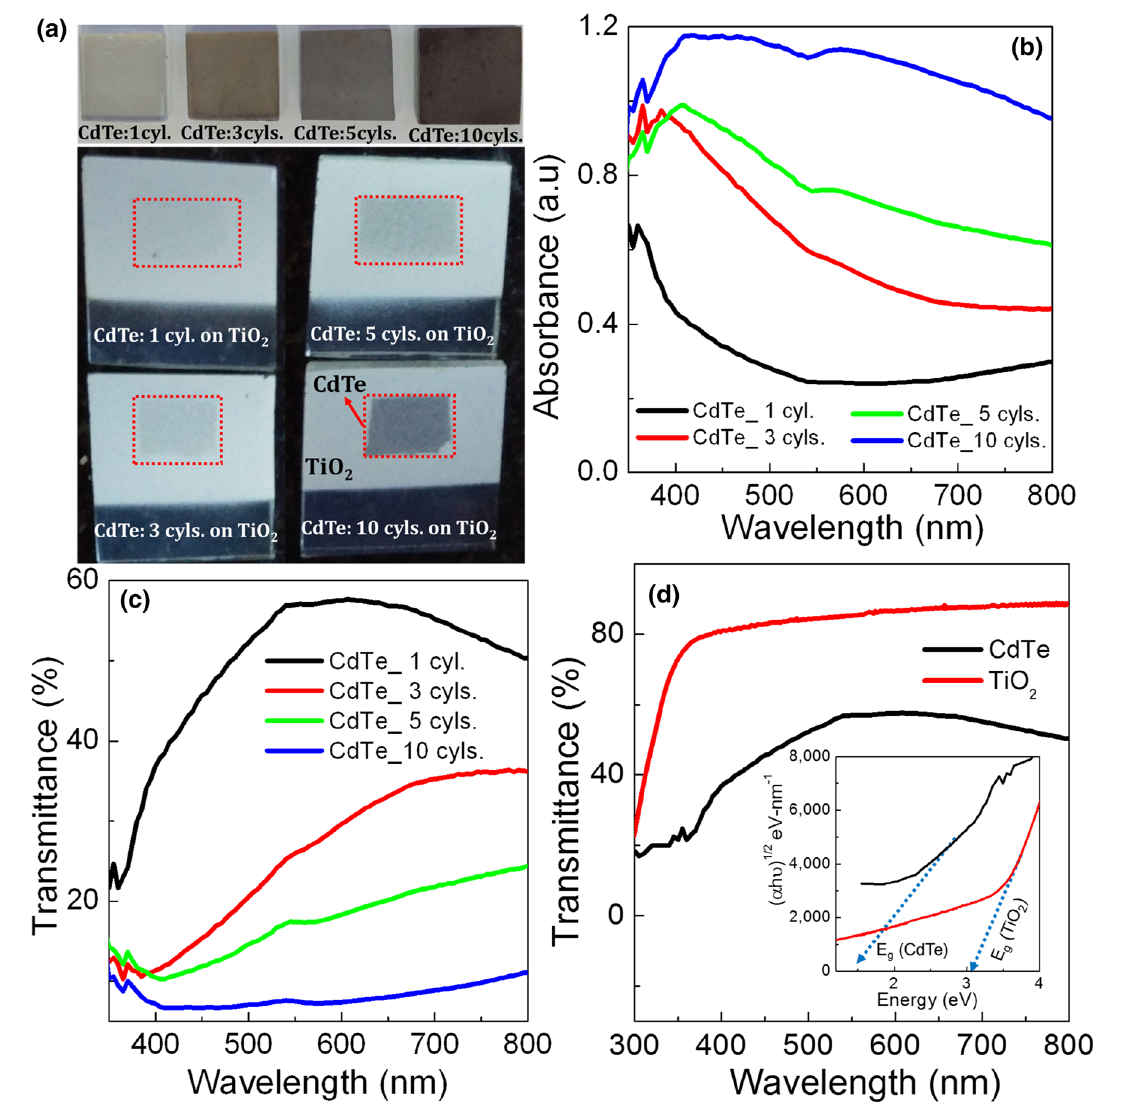
Fig. 4 a Photographs of SPD-processed CdTe thin films, b opti- cal absorbance of CdTe thin films of 1, 3, 5, and 10 cycles showing thickness dependent variation in absorbance, and c corresponding